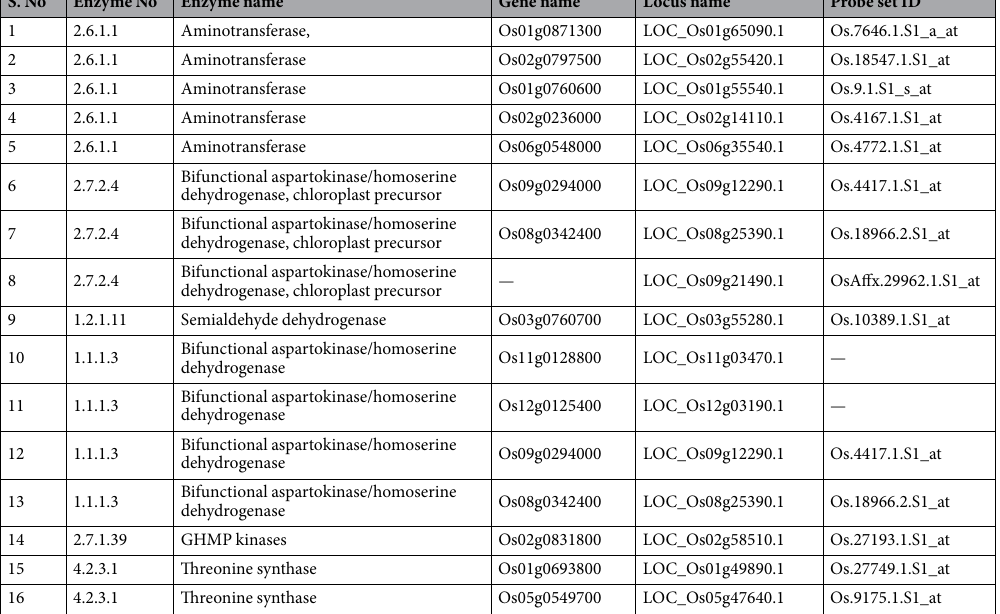
Table 1. Threonine metabolite encoding genes.